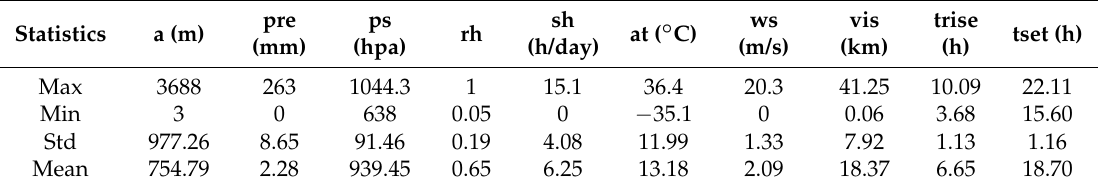
Table 1. The statistical indicators representing the meteorological patterns of the Chinese Ecosystem Research Network (CERN) stations.